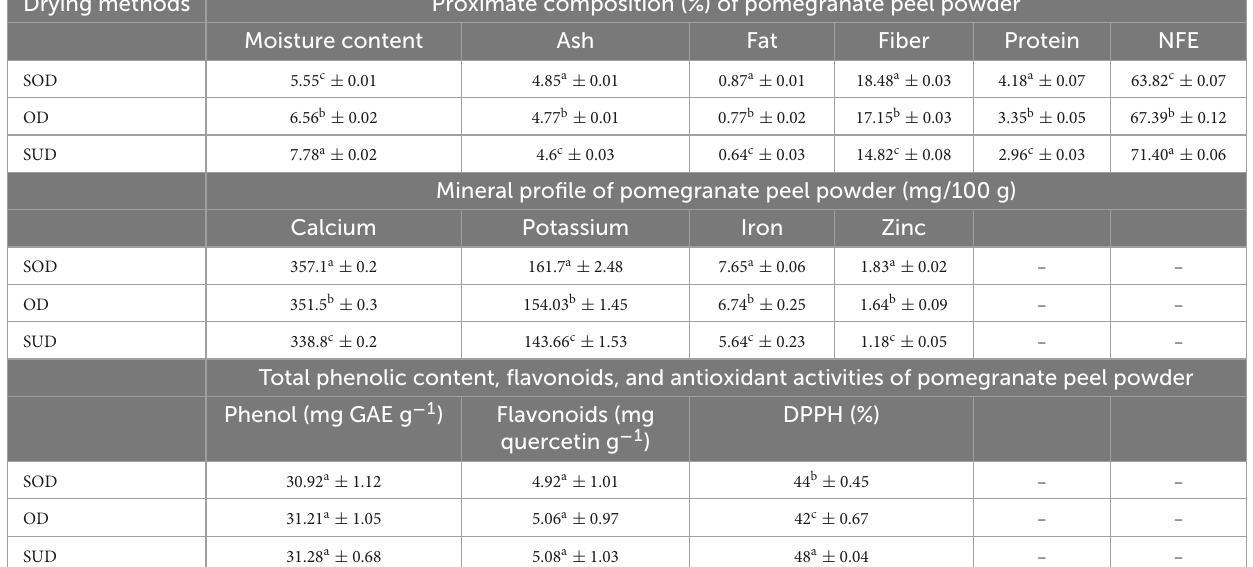
TABLE 1 Proximate composition, mineral profile, and antioxidant activities of pomegranate peel powder dried by various drying methods. Drying